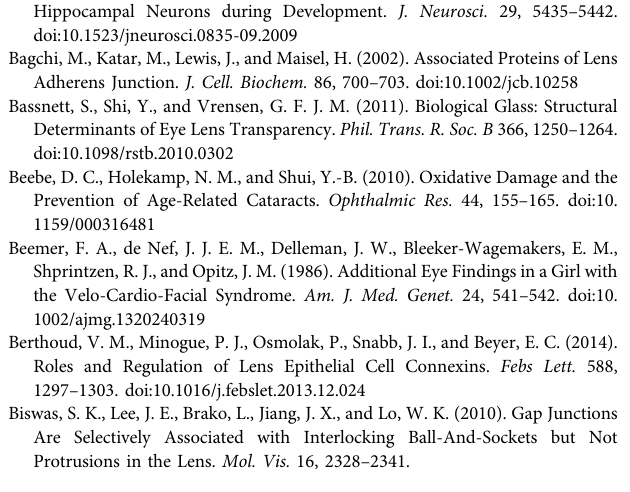
but fi lled with crystallin-containing cytoplasm (green). Note that this indicates that these regions are not intercellular breaks but rather abnormally large regions of cytoplasm. (B) The entire polyacrylamide gel following SDS-PAGE of lysates from control and Arvcf mutant lens lysates labeled for total protein lysate found in Figure 3H is on the left. On the right is the entire western blot of the polyacrylamide gel depicted to the left that has been immunolabeled for Arvcf protein. (C – D) Examples of additional western blots demonstrating the reduction of Arvcf protein in Arvcf − / − lens lysates. The white hatched boxes in D are magni fi ed in panel (C) (E) Equatorial histological sections of control and Arvcf mutant lens fi ber cells found within 50microns of the surface co-immunolabeled with p120-catenin (green) and β -catenin (red). Note that p120-catenin is not strongly localized to lens fi ber cell membranes in control lenses but is more apparent in the lens fi ber cell membranes of mutant lenses. (F – J) Box and whisker plots that describe the quantitative data depicted in Figures 4 , 5 . The line within each box represents the median value, the boxes span the fi rst and third quartiles, the x symbol represents the mean, the whiskers represent the range of all values not considered outliers, and the circles represent the outlier values that are outside 1.5 times the interquartile range. Scale bars = 10 microns. Supplementary Figure S4(A – B) | Lowerand highermagni fi cationSEM imagesofa whole bisected lens or a small region of the lens approximately 100 microns from the surface from control (A) or Arvcf de fi cient lenses (B) . In panels A ′ and B ′ a single lens fi bercellwaspseudocoloredgreentovisualizetheirelongatednature.Thescalebarsin A and B = 300 microns and the scale bars in A ′ and B ’ = 5 microns. (C) Image of an individualinterlockingprotrusionfroman Arvcf − / − lensimmuno fl uorescentlyco-labeled with antibodies speci fi c for β -catenin (green C ” ) or aquaporin-0 (blue C ′ ). The diagram to the right indicates the strategy for comparing immuno fl uorescent images of individual protrusions. The numbers represent individual pixels labeled by position. The pixels at the same location (those that have the same position number) were comparedamongeachprotrusionimagebyquantifyingthemean.Thesemeanswere used to generate the average image in Figures 7C,D,I,J and used to perform the subsequent statistical analyses. (D) A single wild-type lens fi ber cell immuno fl uorescently labeled with an N-cadherin and aquaporin-0 antibody. Note thatthislens fi ber cellwas prepared bypullingindividual fi ber cells apart. (E) Magni fi ed images of the regions indicated by boxes in panel (D) . Yellow asterisks mark cellular protrusion outlines that lie on the surface of lens fi ber cells. These outlines are well delineatedbybothN-cadherinandAqp0localizationandarethoughttocorrespondto the “ pocket ” of an interlocking protrusion from a neighboring cell. Note that these are typically outlined well and are unaffected by dissection. This stands in contrast to the protrusions that extend into space following manual dissection (arrowheads). These are readilyvisualizedby Aqp0 localization but not N-cadherin. (F) A group ofwild-type lens fi ber cells immuno fl uorescently labeled for Arvcf and N-cadherin were imaged withoutdissectingthemfromeachotherbuthaveaslightseparation.Theyellowboxed regions are magni fi ed inthe small panels tothe right.Note that N-cadherinappears to haveasimilarlocalizationpatterntotheirneighboringcellsalongthemarginsofpaddle regions. This also apparent in interlocking protrusions (bottom right panel, asterisks). Scalebars in (D – F) = 2000